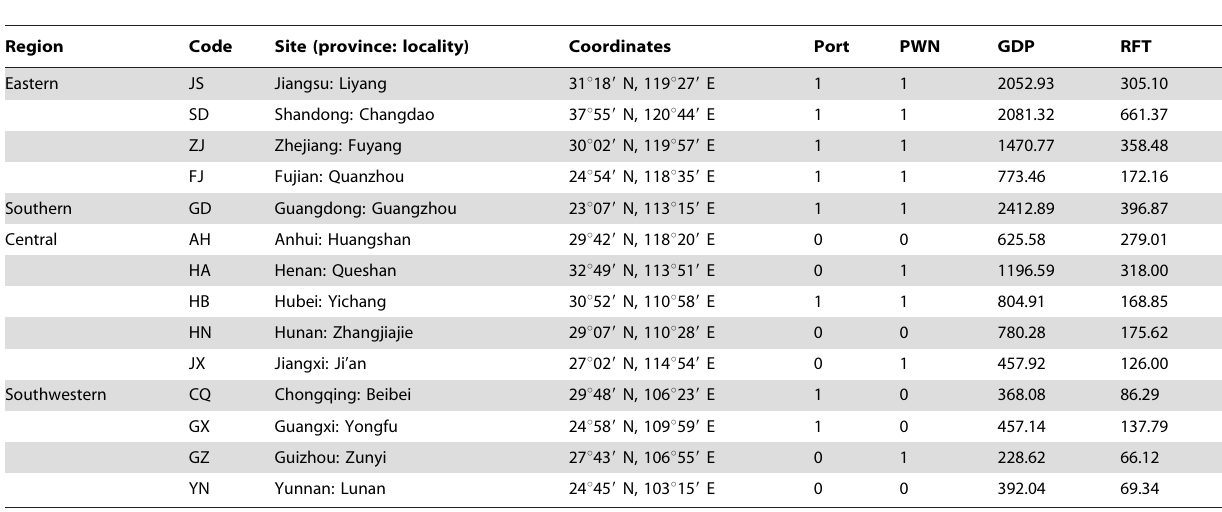
Table 1. Summary information of the 14 sampling localities for M. alternatus , arranged by the geographical regions within mainland